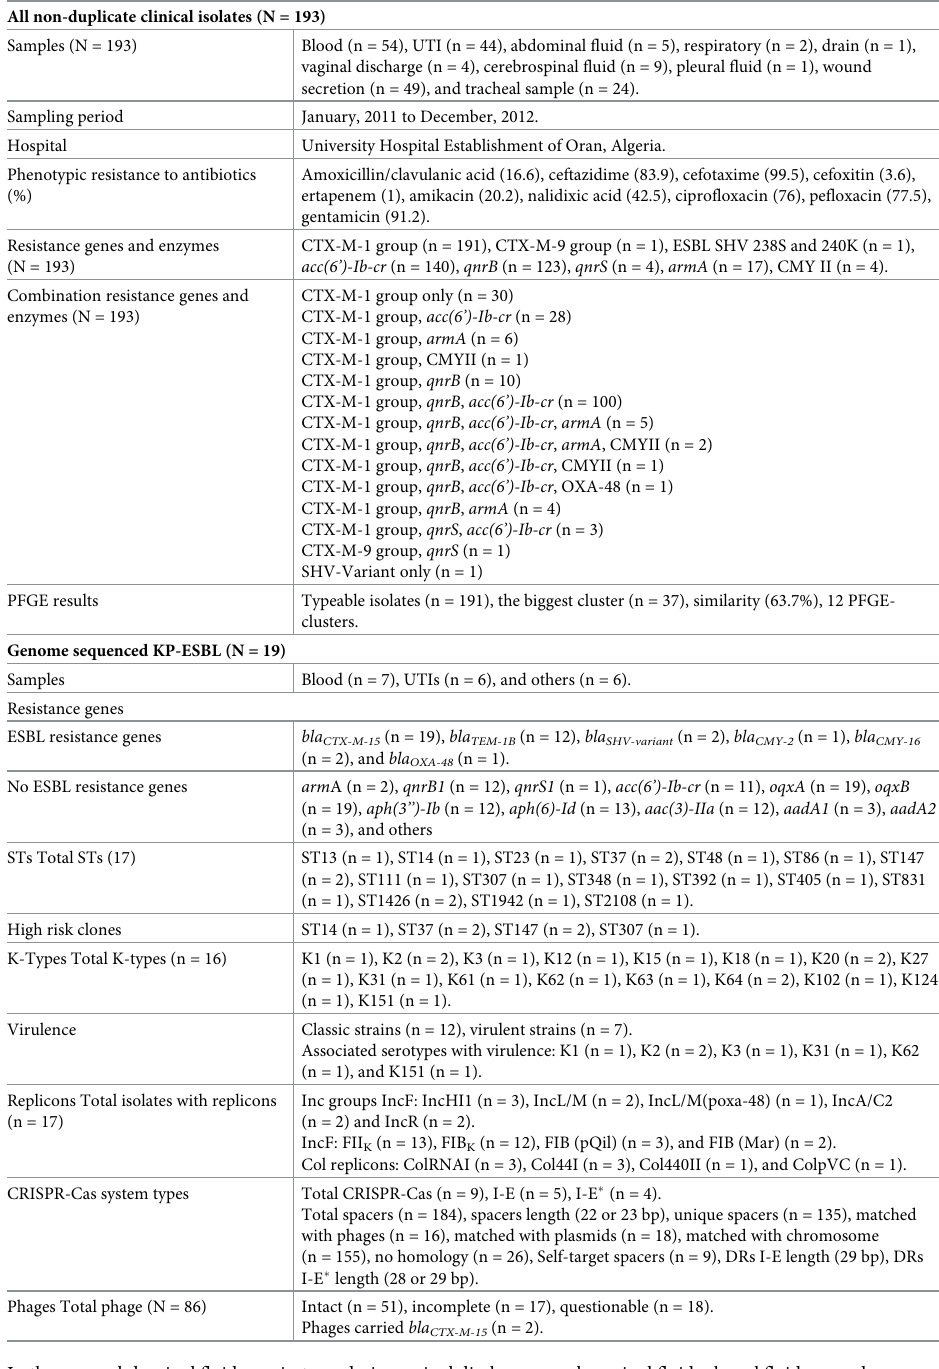
Table 1. Summary of the main findings. All non-duplicate clinical isolates (N =